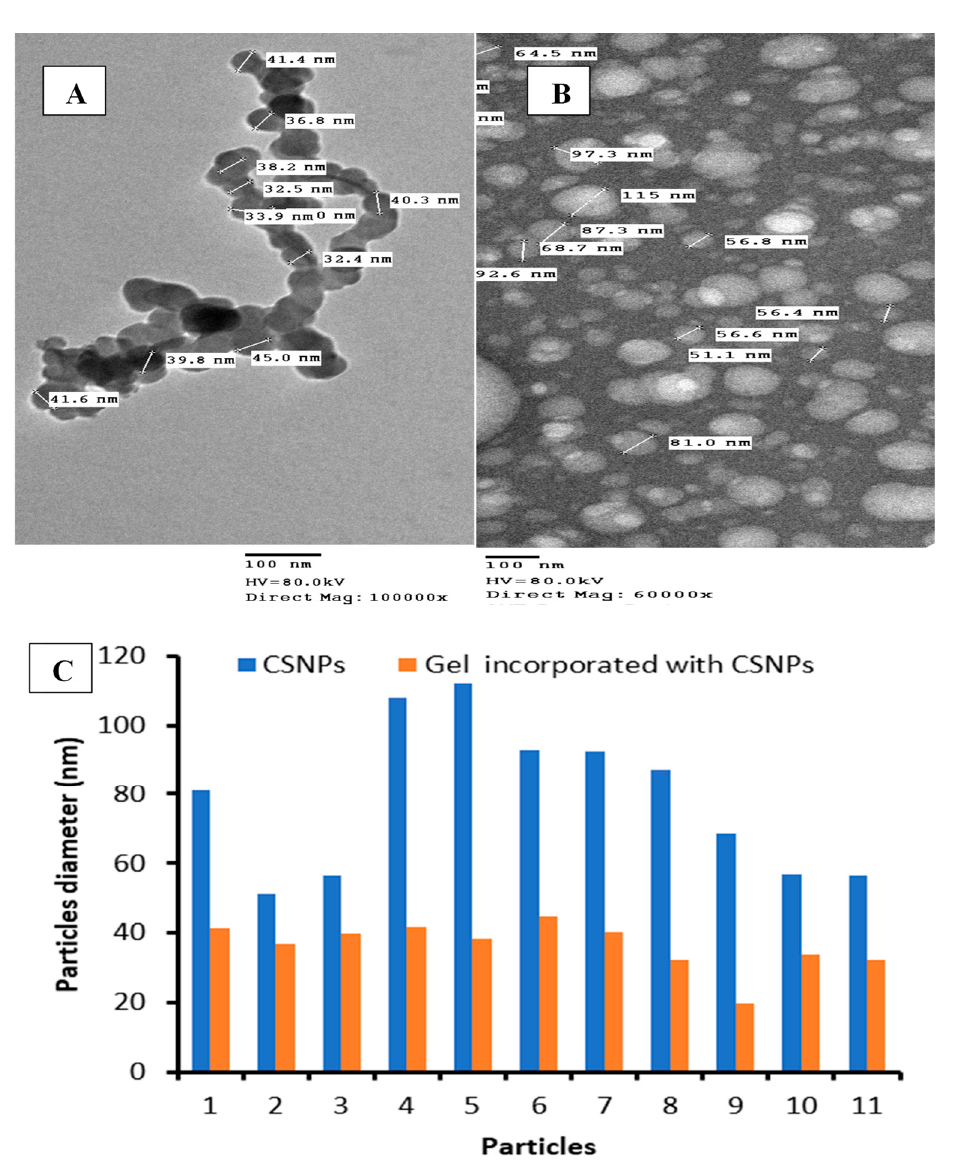
Figure 4. TEM of synthesized A. vera gel incorporated with CSNPs ( A ), CSNPs ( B ), and diameter of some particles ( C ).